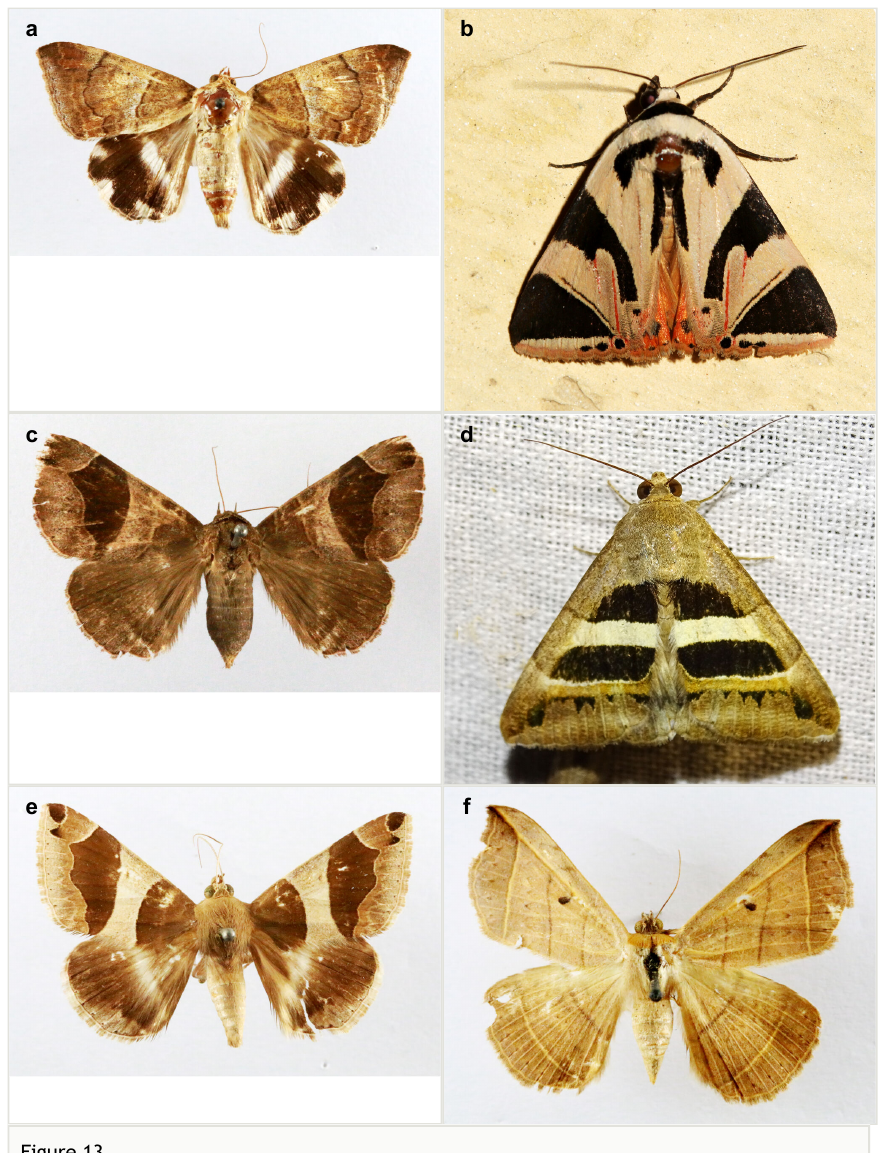
Adults of a. Achaea janata ; b. Attatha ino ; c. Bastilla joviania ; d. Buzara onelia ; e. Dysgonia